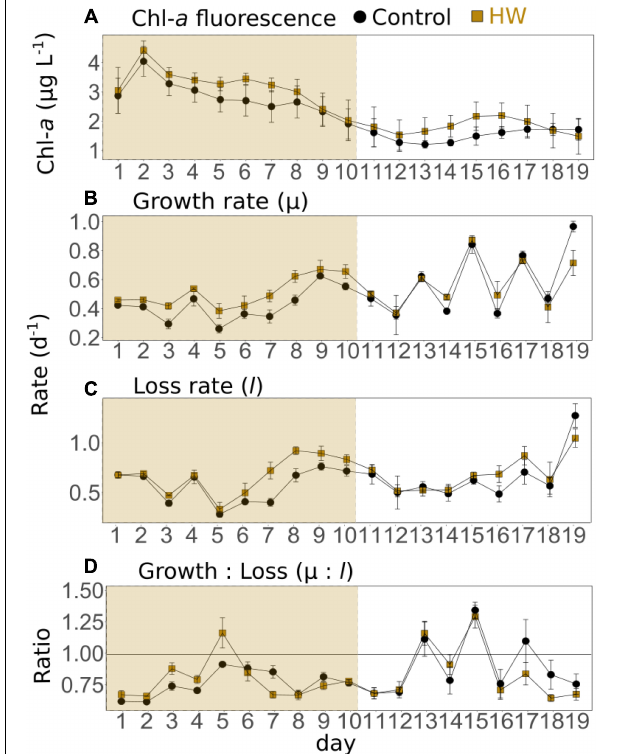
FIGURE 2 | Daily means of phytoplankton chlorophyll- a fluorescence (corrected for NPQ, A ), µ (B) , l (C) , and µ : l (D) in the control (black) and HW (gold) treatments. The gold shaded area represents the HW period during which the +3 ◦ C was applied in the HW mesocosms. Error bars represent the standard